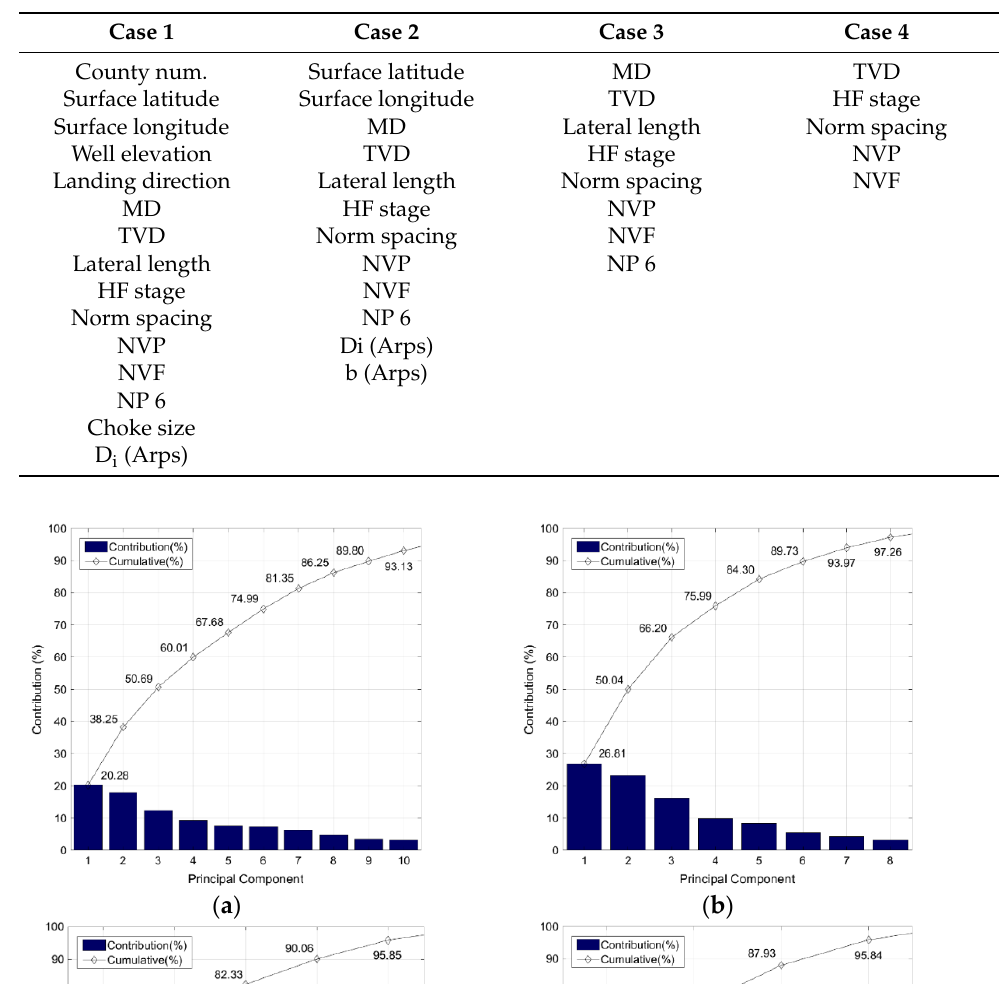
Figure 10. Visualization of the PCs in 3D plot for Case 4. 4.3. Analysis of Production Characteristics Using Group Classification To classify the groups based on the PCA results, fuzzy c-means were used, which indicates the possibility that an individual belongs to several clusters and is considered one of the most representative fuzzy cluster analyses. In this study, fuzzy cluster analyses were performed 10 times using the three PCs of Case 4, which consisted of the key factors from the PCA. This was verified by confirming that the objective function converged to a constant value in all trials. The number of wells in the three groups was 50, 74, and 96,